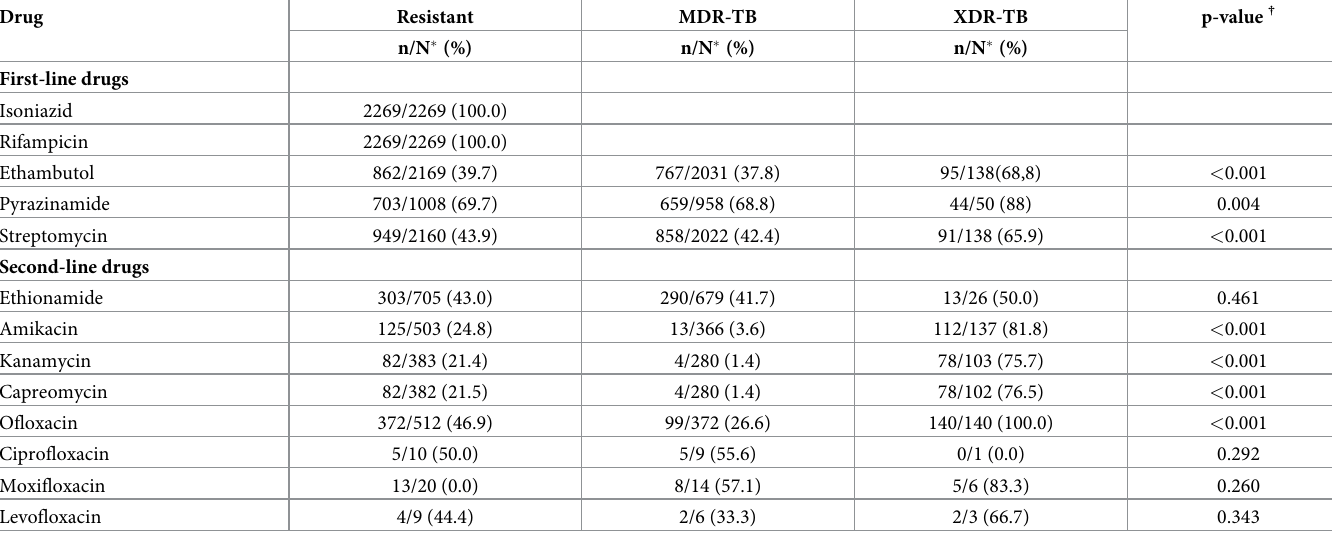
MDR-TB = multidrug-resistant TB.